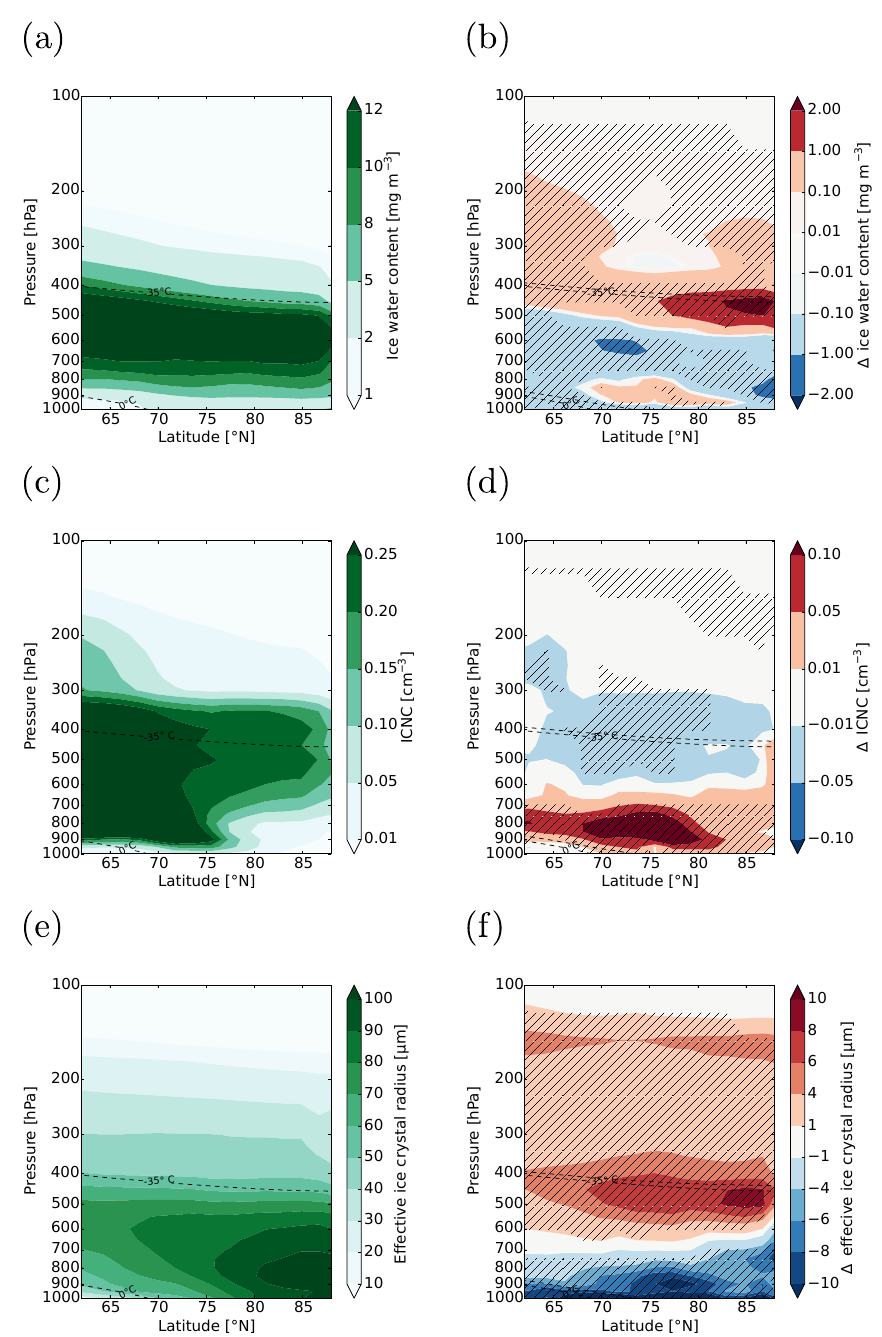
Figure 5. IWC, ICNC, and effective ice crystal radius in 2004 in (a) , (c) , and (e) and differences between 2050 and 2004 (i.e. between simulations arctic_2050_EM2004 and arctic_2004) in (b) , (d) , and (f) (in-cloud values) in early autumn (September–October). Hatched areas are significant at the 95% confidence level. The dashed lines show the 0 and the − 35 ◦ C isotherms. Note that they are zonally and temporally averaged, and hence ice can exist at altitudes below the 0 ◦ C